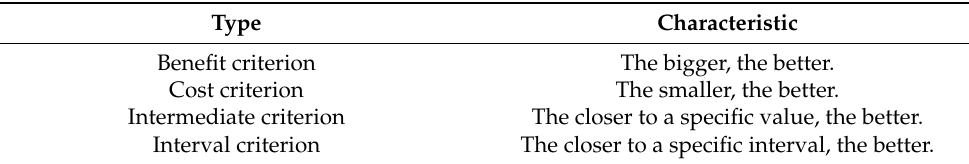
Table 2. Four common types of criteria used in the technique for order of preference by similarity to ideal solution (TOPSIS) scheme and their characteristics. Type Characteristic Benefit criterion The bigger, the better. Cost criterion The smaller, the better. Intermediate criterion The closer to a specific value, the better. Interval criterion The closer to a specific interval, the